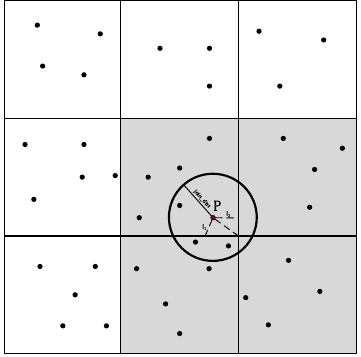
Figure 4. Grid cell partitioning.